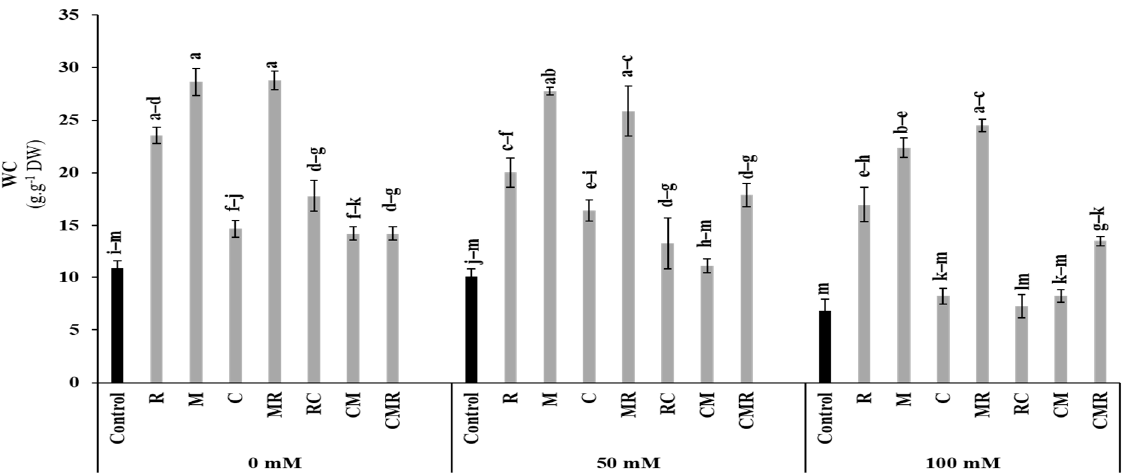
Figure 6. Impact of salt stress (0, 50, and 100 mM NaCl) on water content (WC) in lettuce subjected to different biostimulant treatments; control plants (non–amended, non–inoculated), and plants inoculated with plant growth promoting rhizobacteria (R) and/or arbuscular mycorrhizal fungi (M), and/or amended with composts (C). Means (±SE of 5 biological replicates) followed by the same letters are not significantly different at p < 0.05 (Tukey’s HSD).